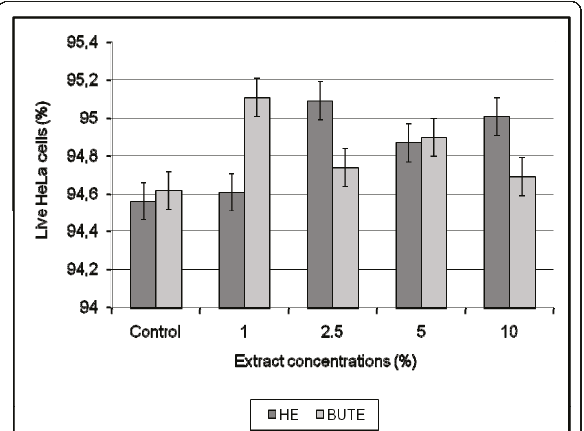
Figure 4 Percentage of live HeLa cells after contact with different concentrations of the hydroalcoholic (HE) and butanolic (BUTE) extracts from S. saponaria , with no significant difference between the controls and extracts at all concentrations tested (p > 0.05) . Mean of live cells in the concentrations of HE = 94.22 ± 0.1555; Mean of live cells in the concentrations of BUTE = 94.41 ± 0.1131 (IC 95% = -0.6295 to